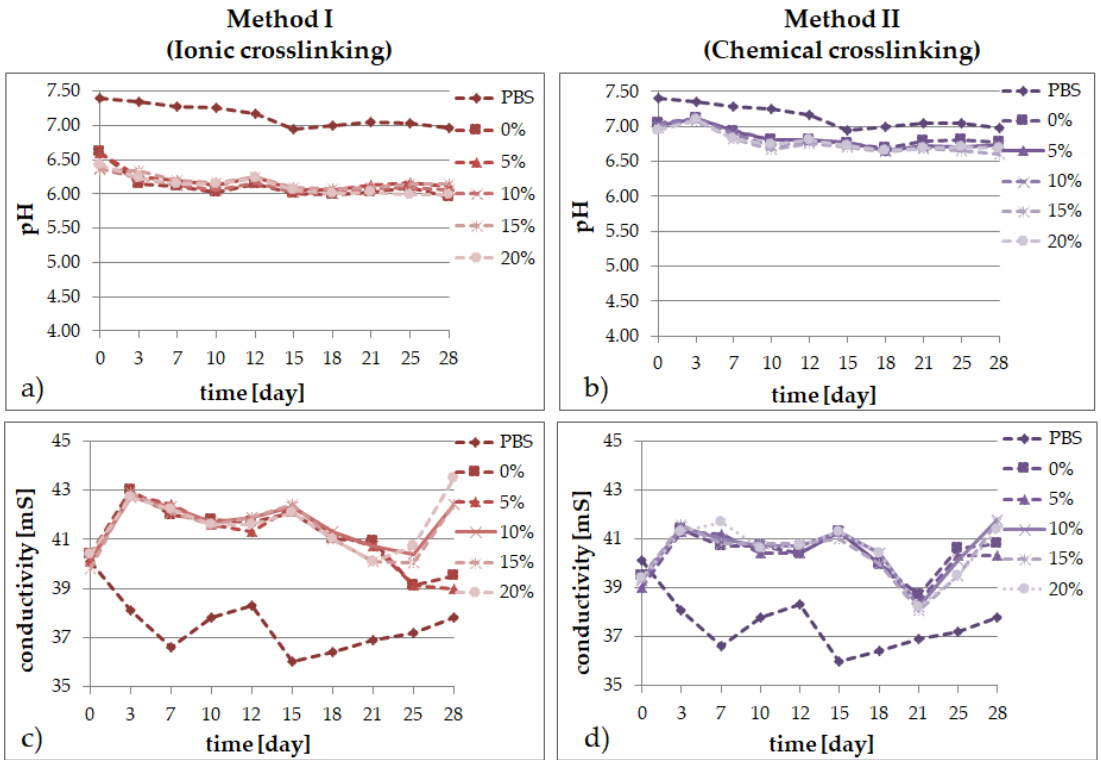
Figure 4. Changes of PBS fluid during 28 days for SA/PVA/ EP hydrogels prepared using method I (left side) or method II (right side) in pH value ( a , b ) and conductivity ( c , d ).